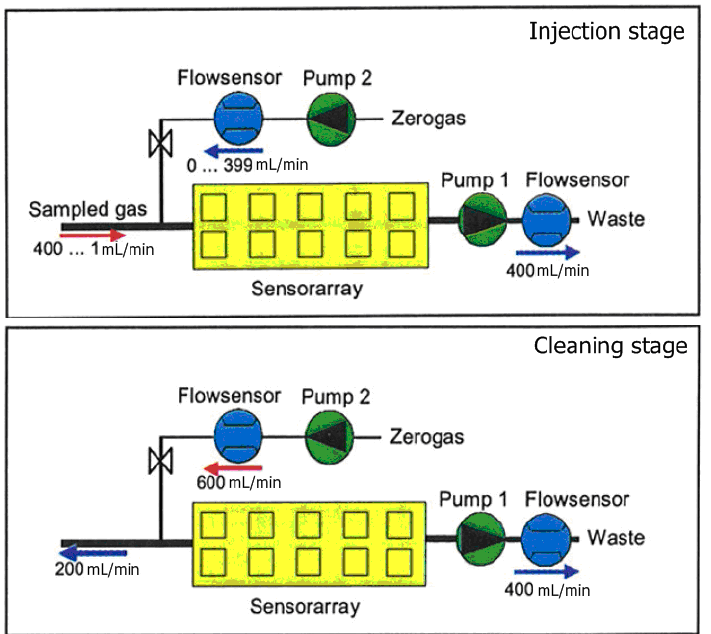
Figure 1. Schematic diagrams of the gas flow of PEN3 during the electronic nose